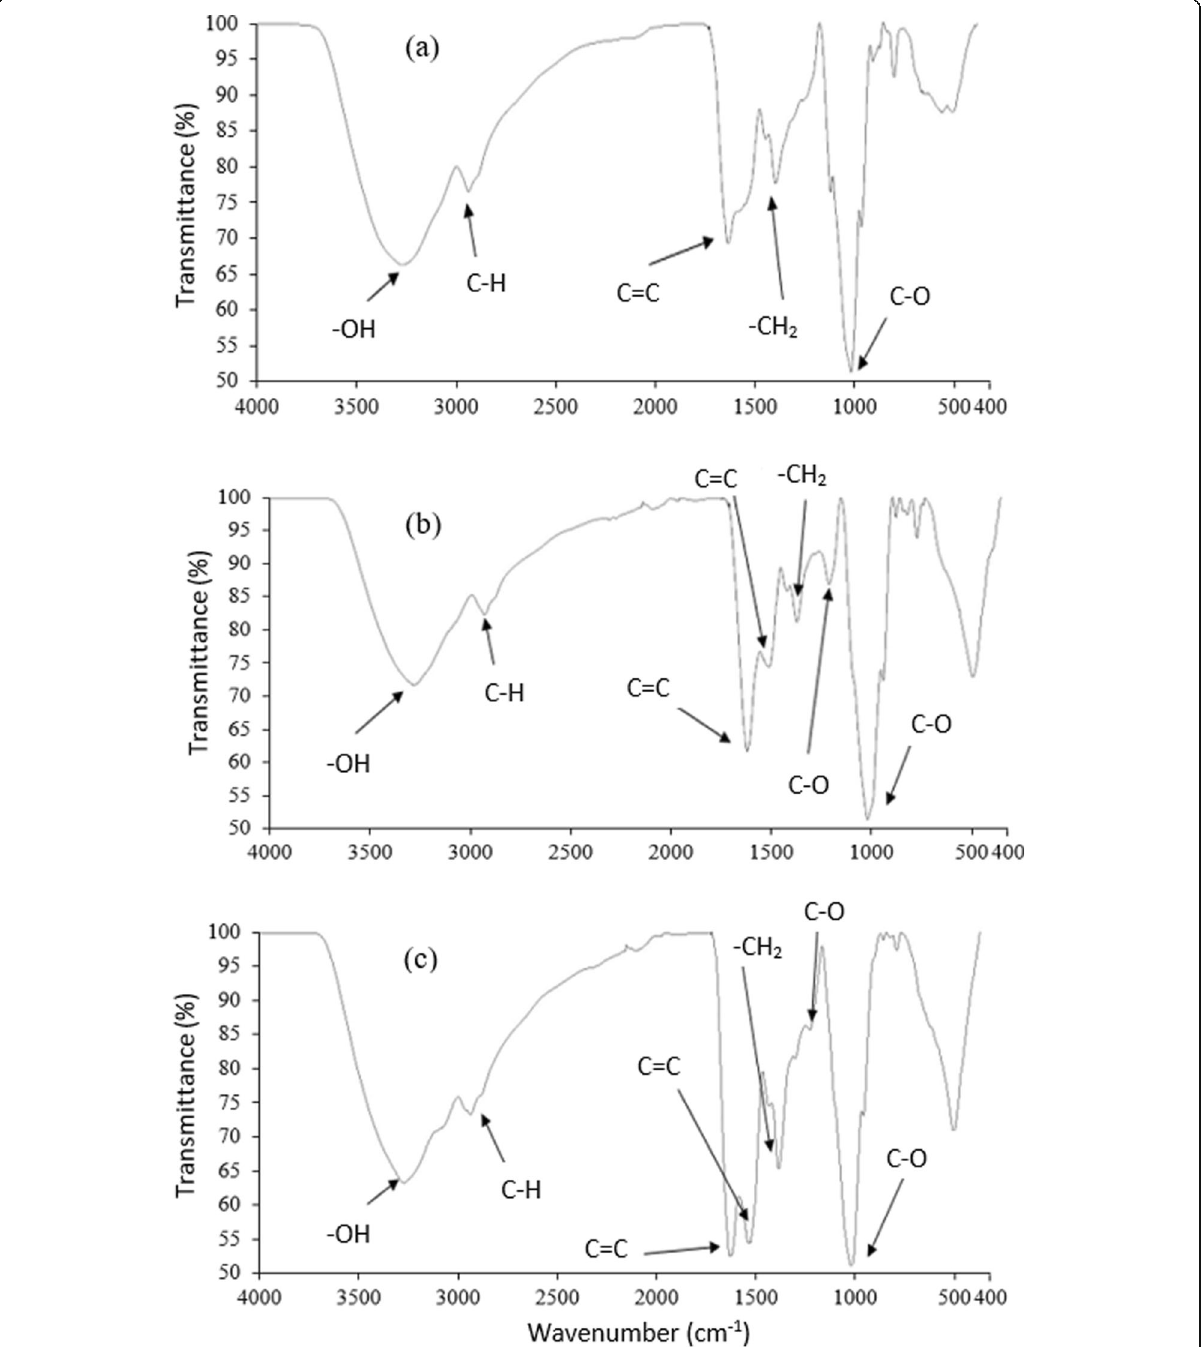
Fig. 2 FTIR spectrum for EPS from ( a ) B. cereus ( b ) T. asperellum ( c ) co-culture, indicating functional groups detected. The peaks indicate